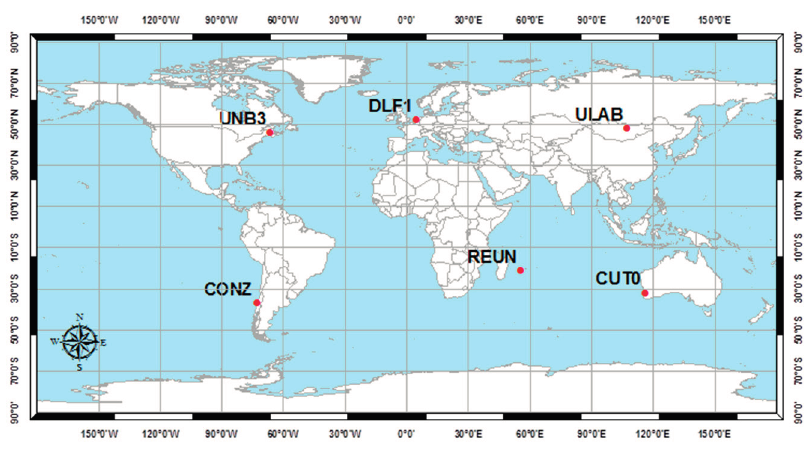
Figure 6. Analysis stations.